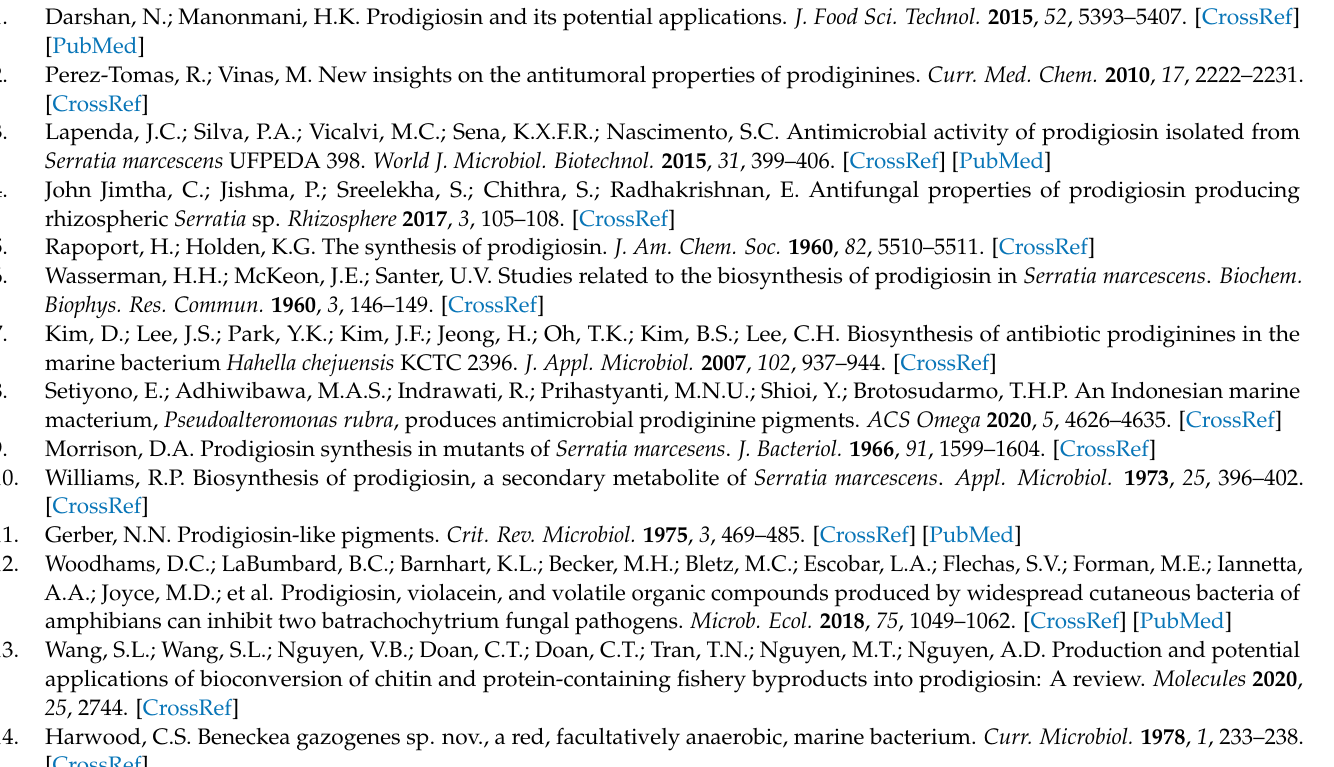
.3390/molecules27186030/s1, Figure S1: Extraction of prodigiosin, Figure S2: Absorption spectrum of acetone-extracted prodigiosin, Figure S3: 13 C CRAPT NMR (CDCl 3 ) spectrum of prodigiosin, Figure S4: 13 C CRAPT NMR (CDCl 3 ) spectrum of prodigiosin (processed with resolution booster and auto-cut spectrum), Figure S5: 1 H NMR (CDCl 3 ) spectrum of prodigiosin, Figure S6: 1 H- 13 C-gHSQC NMR (CDCl 3 ) spectrum of prodigiosin, Figure S7: 1 H- 1 H-gDQFCOSY NMR (CDCl 3 ) spectrum of prodigiosin. Figure S8: 1 H- 1 H-ROESYAD NMR (CDCl 3 ) spectrum of prodigiosin, Figure S9: 1 H- 13 C- gHMBC NMR (CDCl 3 ) spectrum of prodigiosin, Figure S10: 1 H- 1 H-Homonuclear decoupled NMR spectrum of (CDCl3) spectrum of